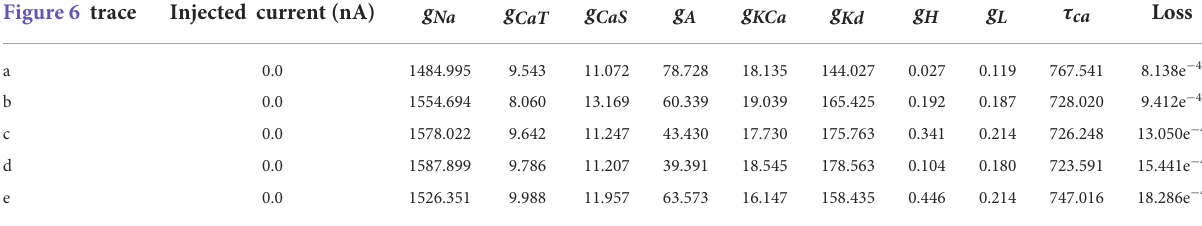
TABLE 5 Parameters for the first 5 solutions for the injected current 0.0 nA. The voltage traces for each of these parameters sets are shown in Figure 6. Figure 6 trace Injected current (nA) g Na g CaT g